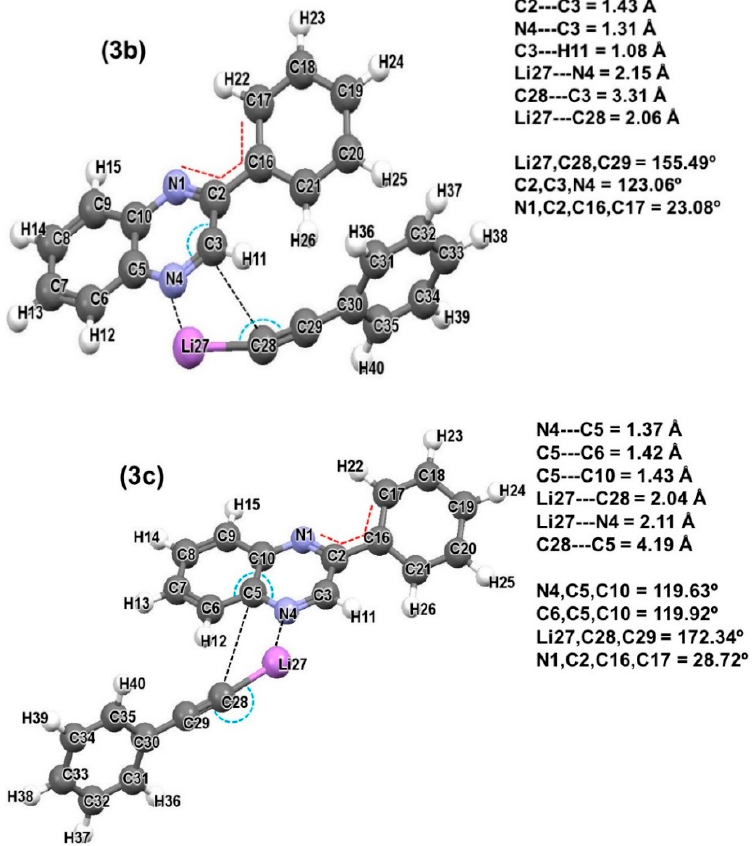
Figure 3. Energy-optimized electronic structures of adducts 3b and 3c showing the selected dis- Figure 3. Energy‑optimized electronic structures of adducts 3b and 3c showing the selected dis‑ tances, angles, and dihedral angles in Å and °, respectively. tances, angles, and dihedral angles in Å and ∘ ,